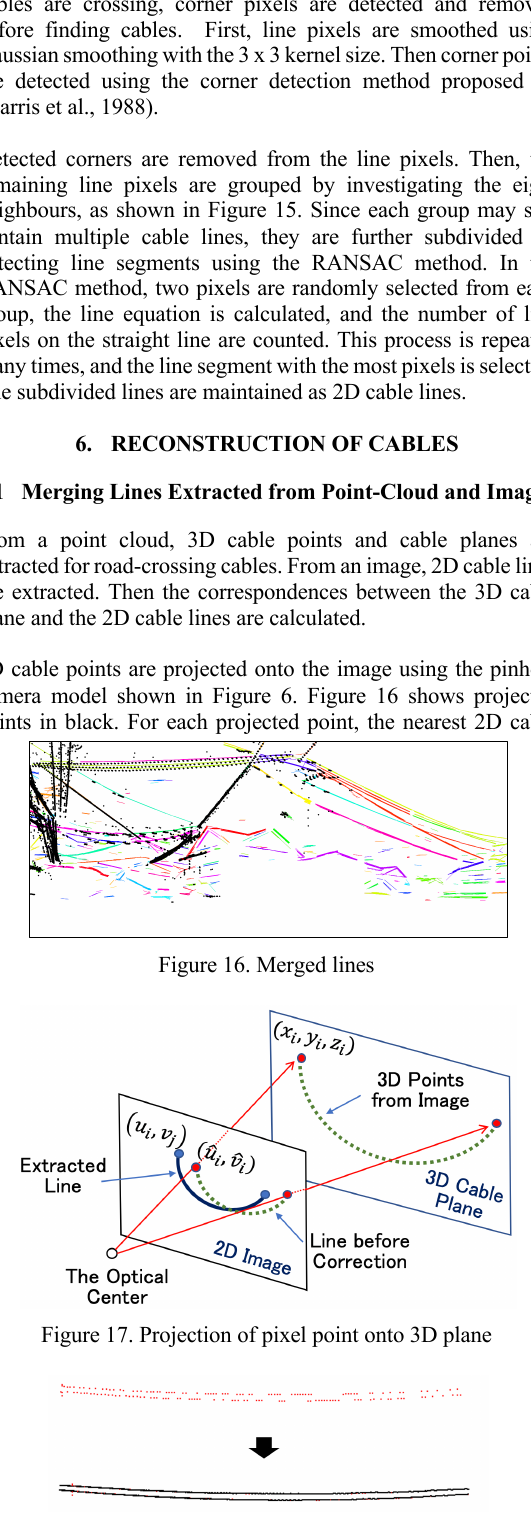
Figure 18. Merged points for road-crossing cables